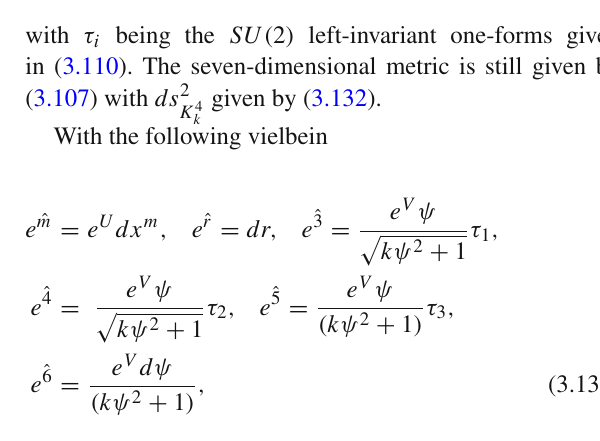
, − 18 ),( 1 , − 12 ),( 1 , − 24 ),( 1 , − 24 ) , 24 16 24 16